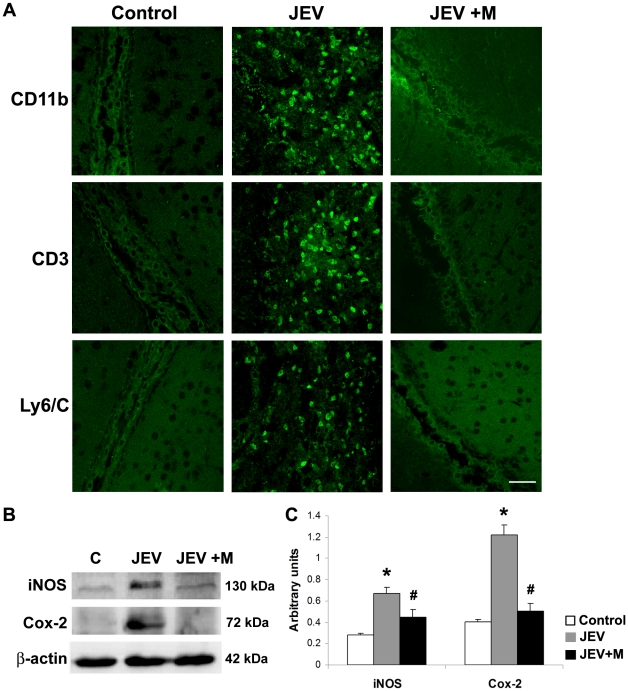
Attenuation of inflammatory milieu in the infected adult SVZ by minocycline administration.Cryostat sections of brains from control, JEV and JEV+M animal groups were stained for cells of monocyte/macrophage lineage (CD11b), T-cells (CD3) and neutrophils (Ly6/C), (FITC, green) (A). Images were acquired using oil immersion lens of confocal microscope. These peripheral immune cells were completely absent in the SVZ of control and JEV+M brains. In SVZ of JEV-infected animals, a large number of these cells were observed; scale bar is 50 µ. Protein isolated from SVZ of control, JEV and JEV+M animals were analyzed by immunoblot (B). Increased expression of iNOS and Cox-2 in JEV-infected SVZ was reduced significantly in JEV+M SVZ. The graphs represent densitometric quantification of proteins bands of iNOS and Cox-2 normalised to β-actin (C). Values represent the means ± SEM from five animals in each group (* significant change from control p<0.01; # significant change from JEV-infected samples p<0.01).